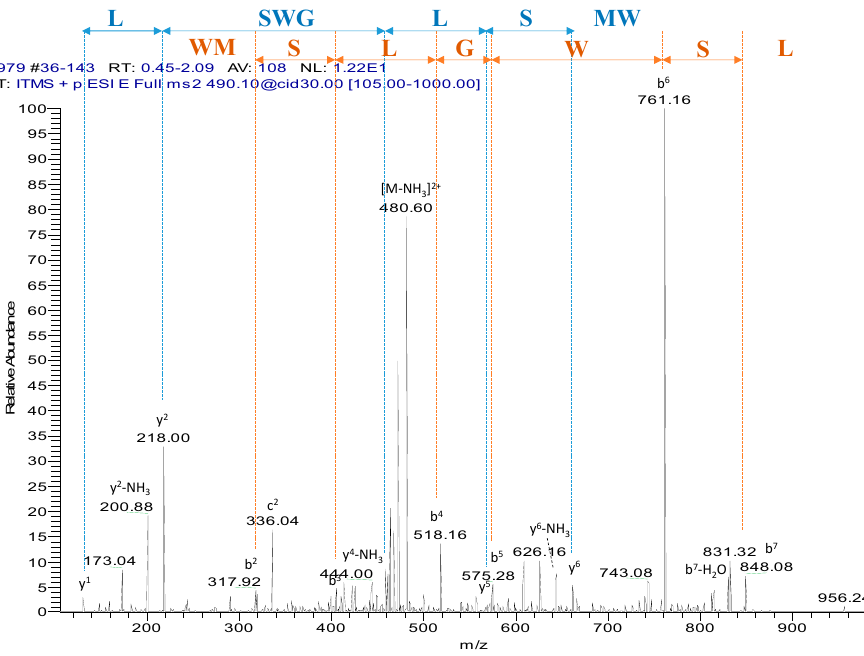
Figure 2. Annotated MS/MS fragmentation spectrum of natural WL-8 amide.